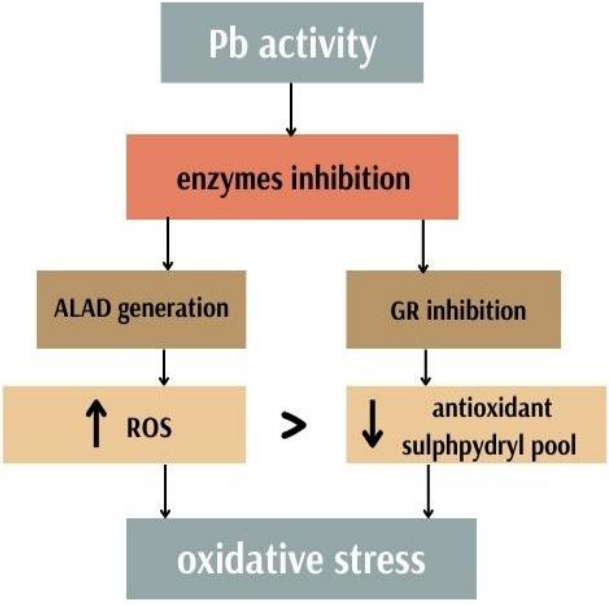
Figure 1. Lead activity and oxidative stress generation.